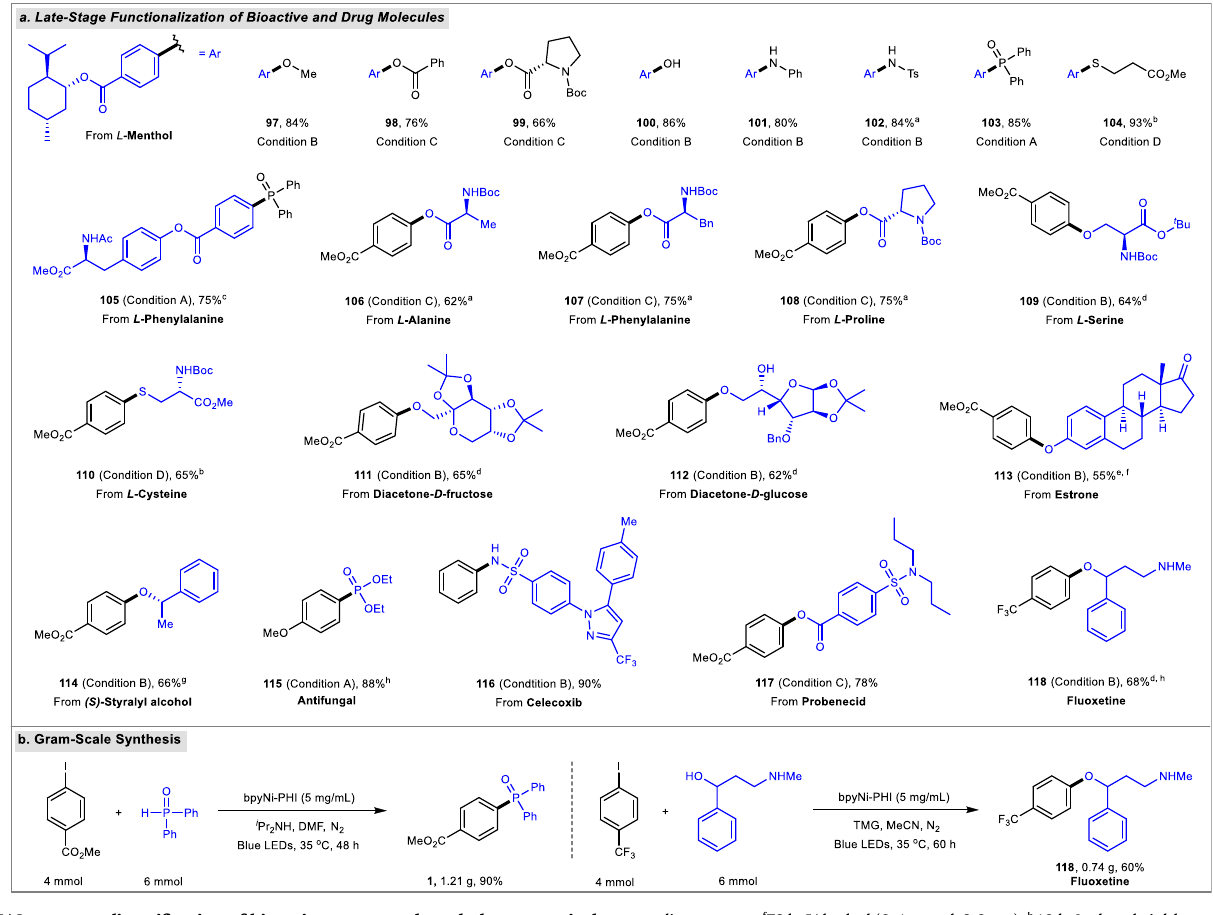
couplingpartner. f 72h. g Alcohol(0.6mmol,3.0eq.). h 60h.Isolatedyieldsaregiven. b Gram-scale synthesis. See Fig. 6 and Supplementary Information for detailed reaction conditions and